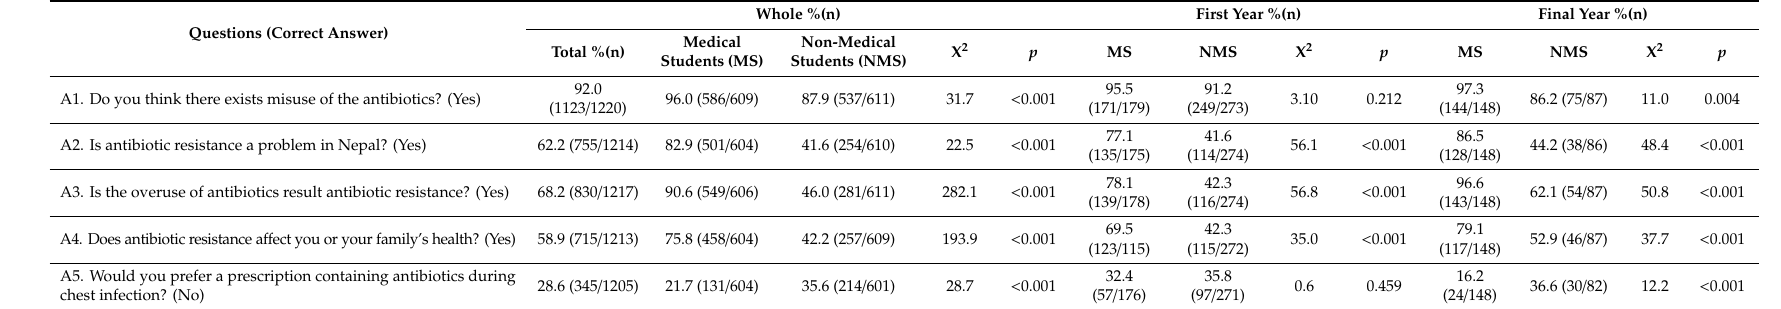
Table 3. Priority items of students’ attitude towards antibiotic